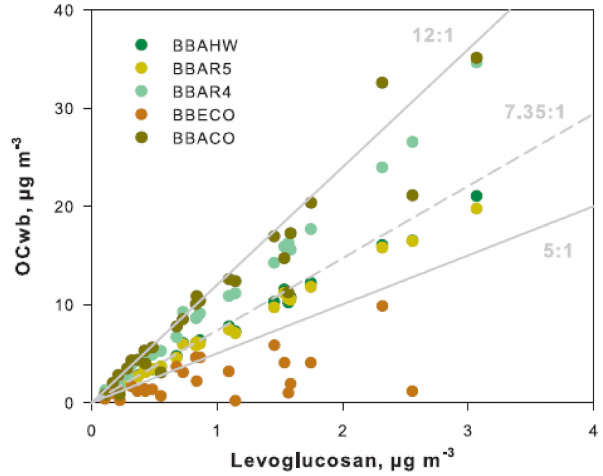
Fig. 3. Biomass burning organic carbon (OC wb ) estimated using Figure 3 CMB modeling with the five selected biomass burning profiles as a function of levoglucosan. The dotted grey line represent the OC- to-Levoglucosan ratio recommended by Puxbaum et al. (2007) for European background environments, while grey lines as used here as